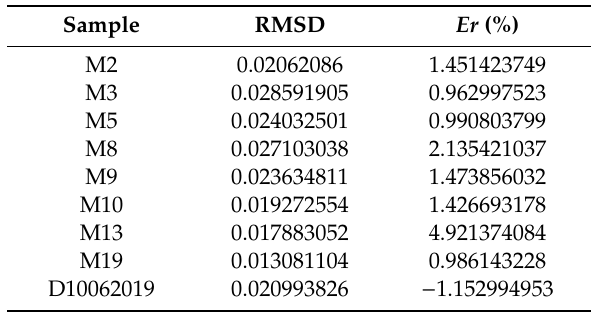
Table 4. RMSD and Error